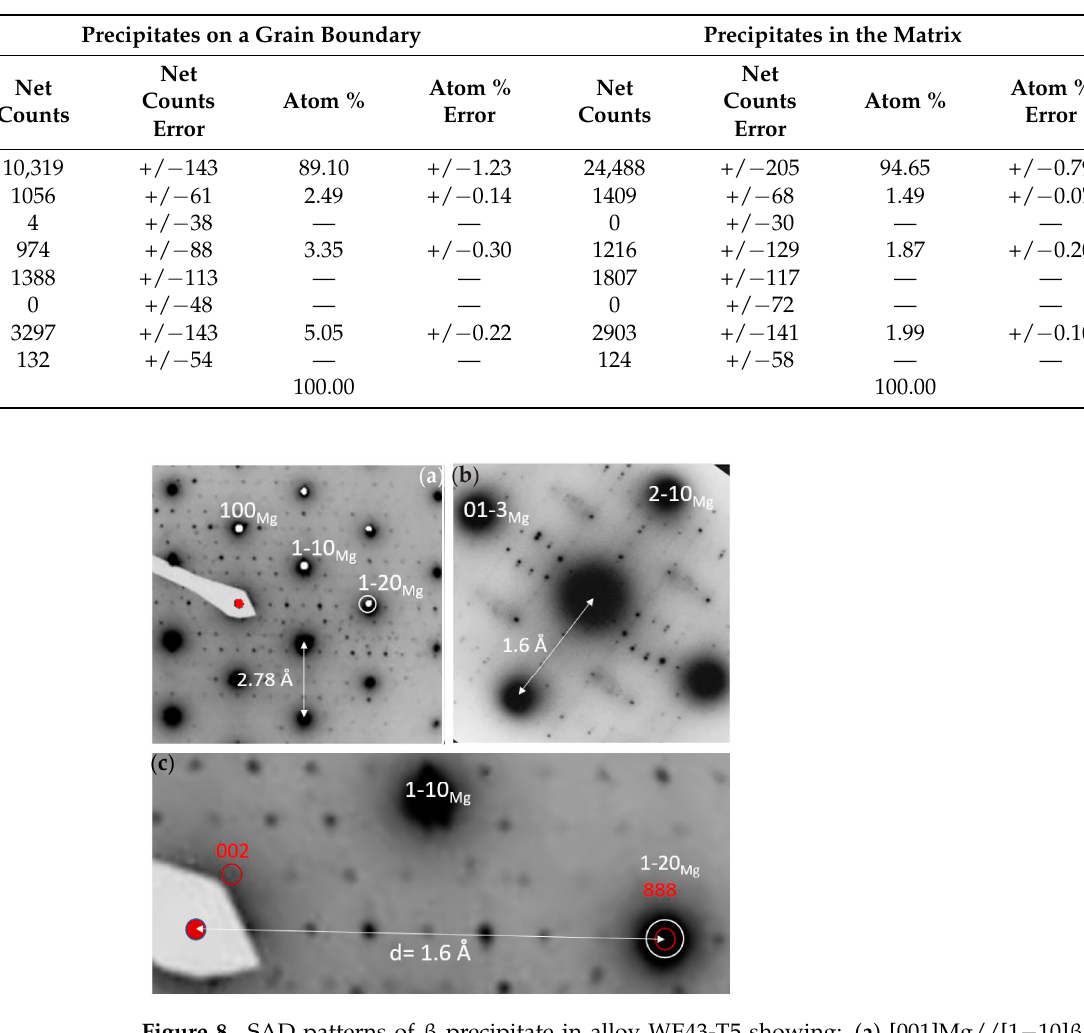
Figure 7. Grain boundary in the WE43-T5 alloy showing a PFZ and precipitates in the matrix and along the grain boundary. Table 4. EDS result from precipitates on a grain boundary and from precipitates in the matrix of alloy WE43-T5. The Cu signal originates from the sample holder.